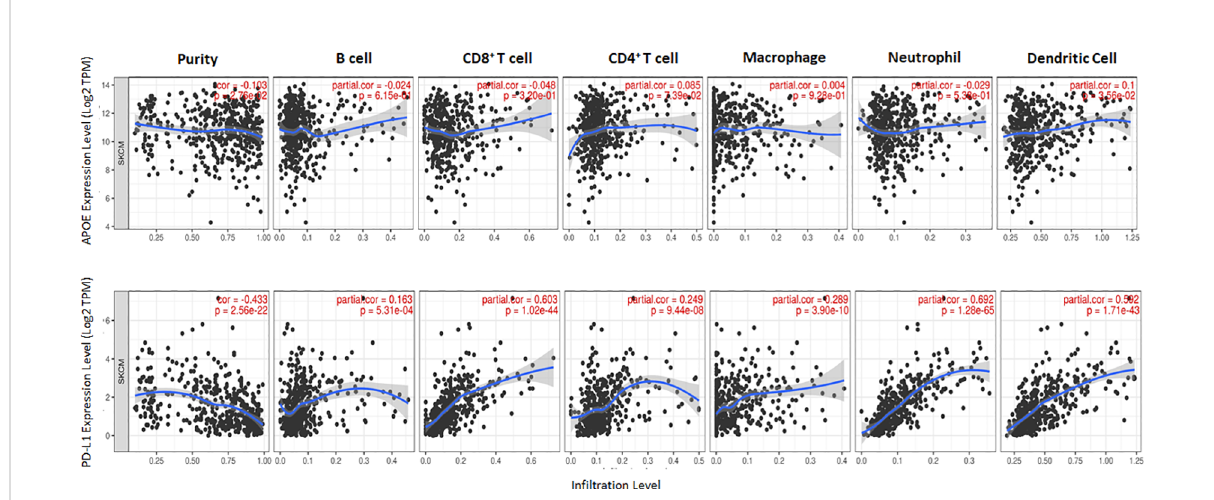
in fi ltrates, while APOE does not correlate with immune cell in fi ltrates. The correlation was evaluated by the Spearman correlation coef fi cient with a cut-off value of 0.5 and P-value used a cut-off value of